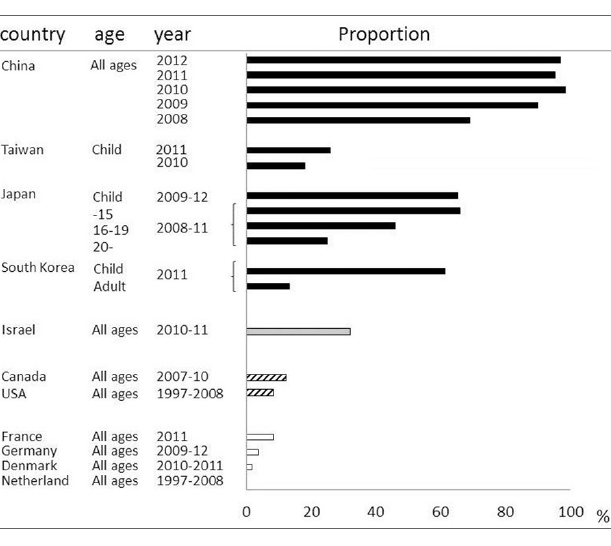
Table 2 | Proportions of macrolide-resistant Mycoplasma pneumonia